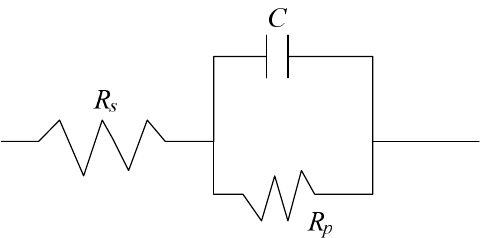
Figure 12. Equivalent circuit model of milling and electrochemical polishing samples. Z ( w 0 ) and Z ( w − ) are calculated by Equation (11) and Equation (12), respectively, in the low-frequency stage ( w = 0) and high-frequency stage ( w = ∞ ).